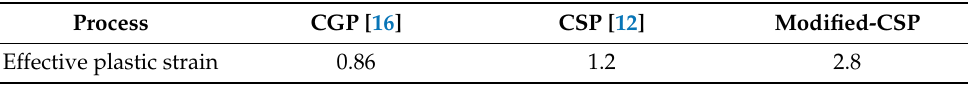
Table 3. Effective plastic strain values in all three methods for the first pass of the process.